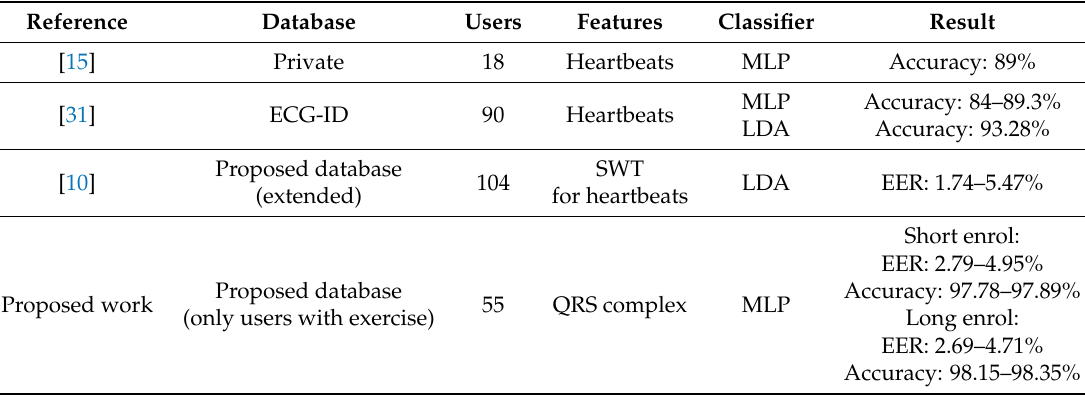
Table 11. Summary of results and tools from state-of-the-art with similar